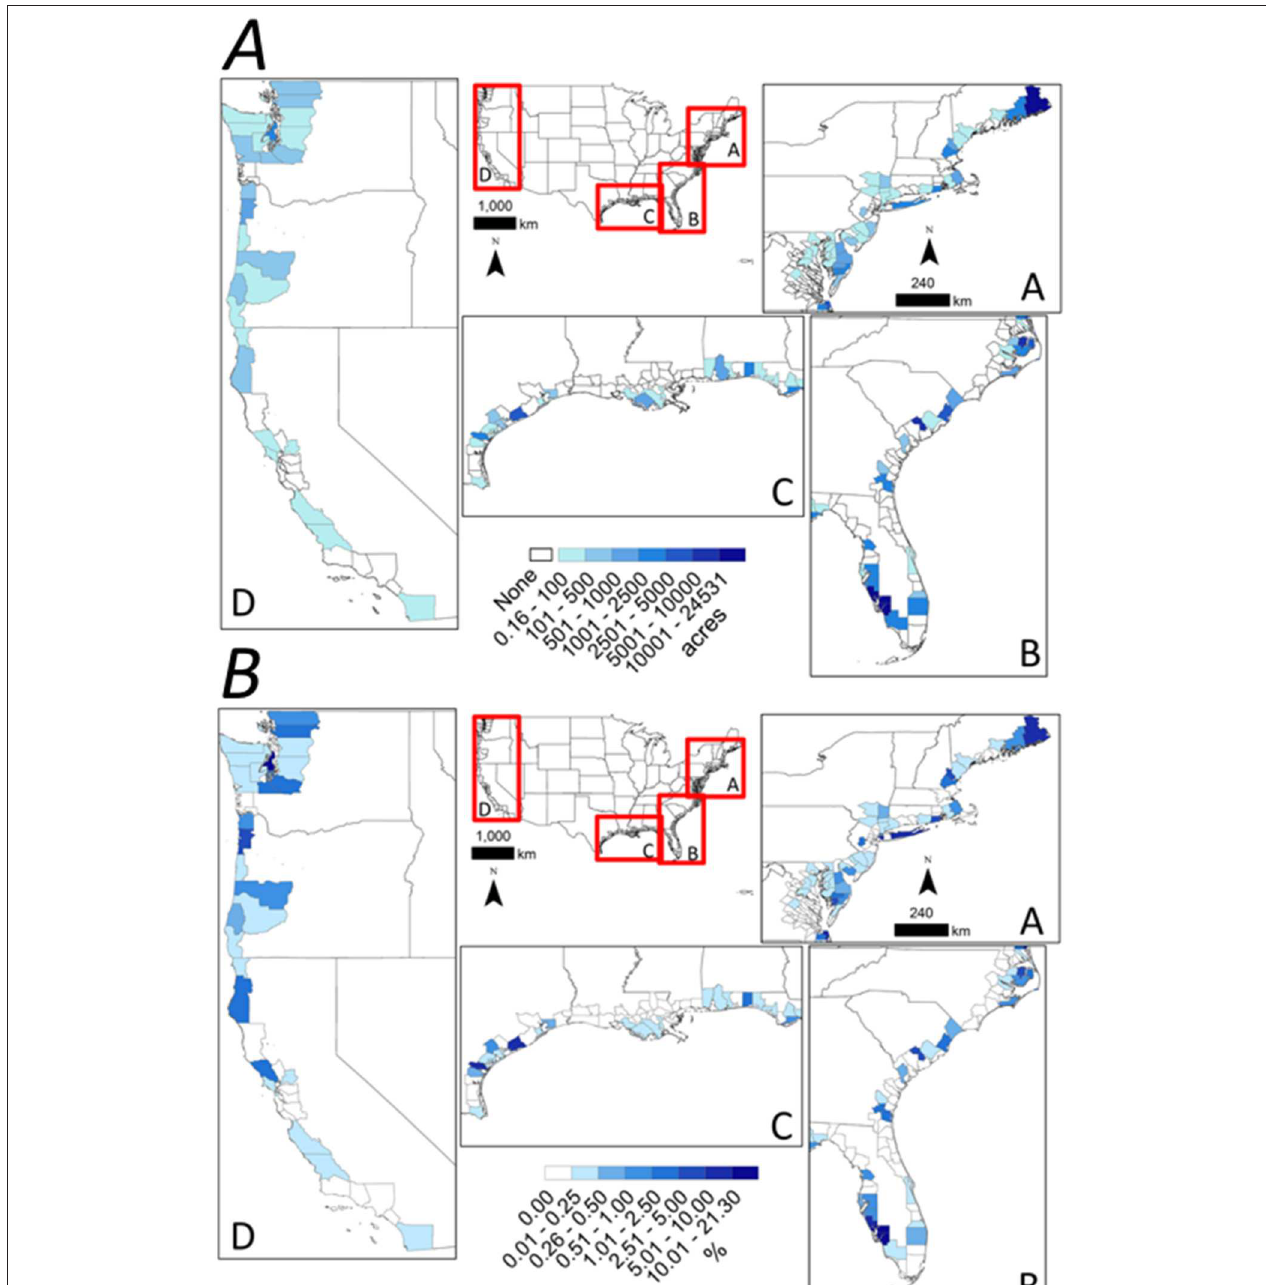
FIGURE 5 | National maps with inset panels showing coastal county-level variation in voluntary palustrine wetland restoration efforts [cumulative acreage (A) and % of 1996 palustrine wetland area (B) ] along the (A) Northeastern coastline, (B) Southeastern coastline and gulf coast of Florida, (C) Gulf of Mexico coastline, and (D) Pacific coastline of the conterminous United